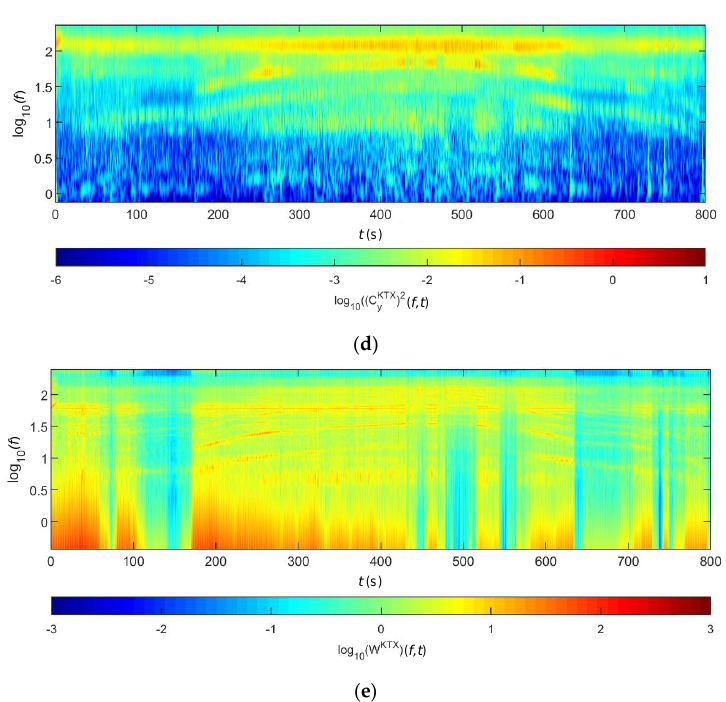
Figure 19. Analysis results of train data: ( a ) velocity; ( b ) lateral acceleration time series; ( c ) STFT; ( d ) WT; ( e ) WVD.